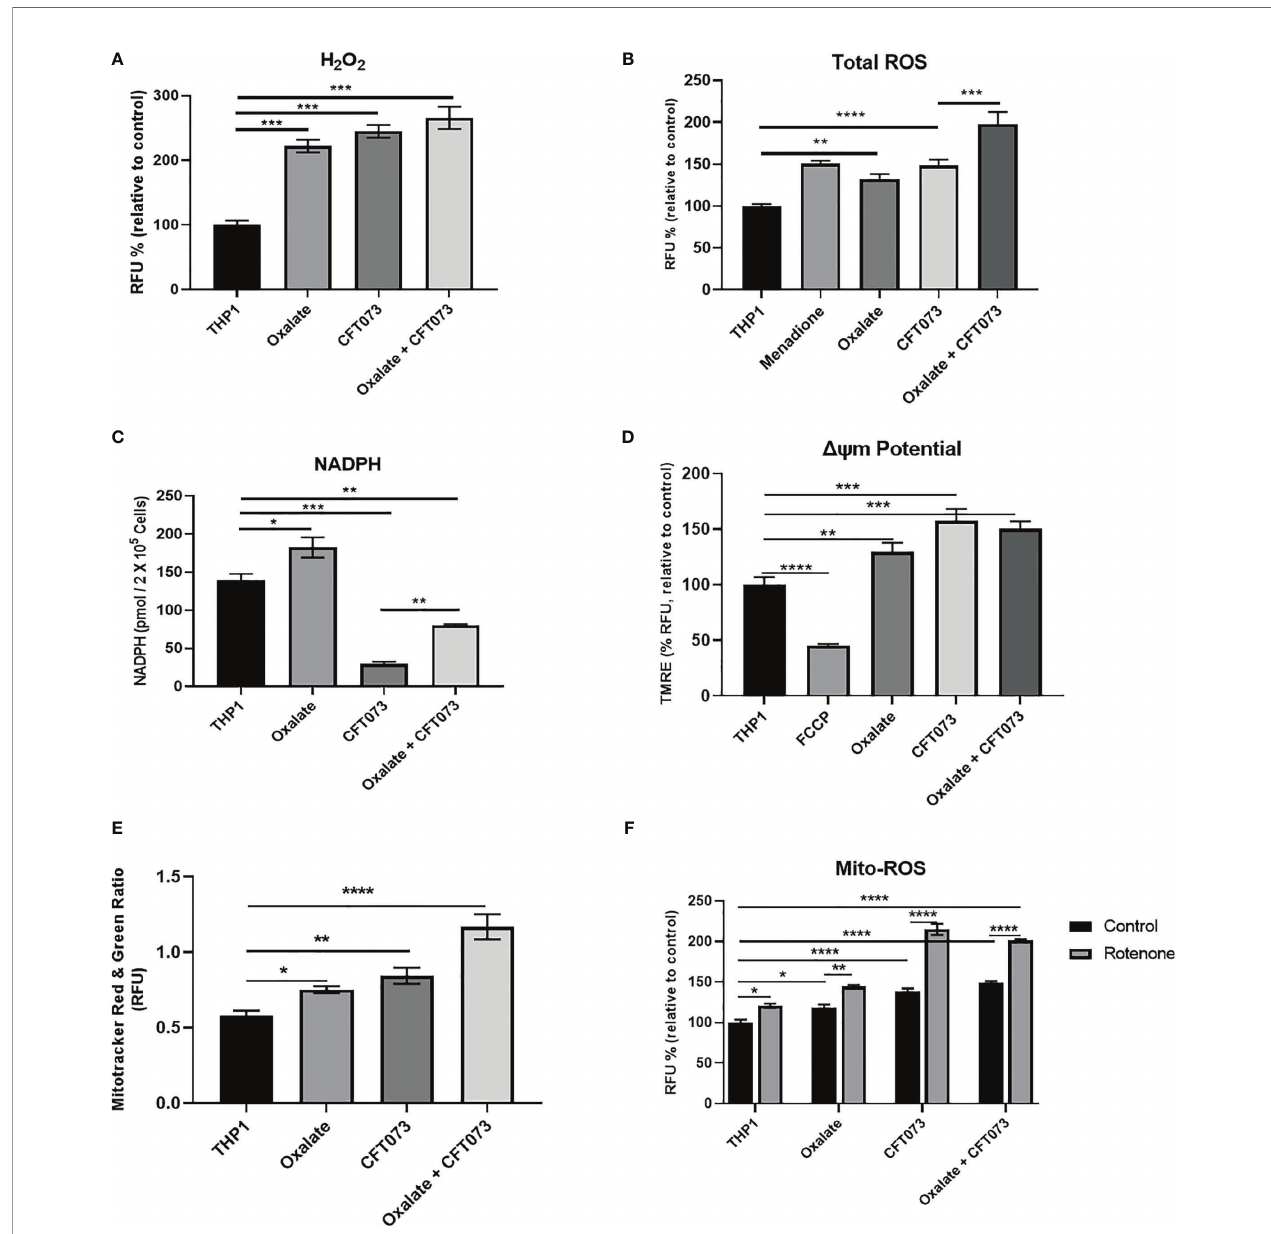
FIGURE 2 | Oxalate increases reactive oxygen species (ROS) levels and mitochondrial membrane potential in THP-1 macrophages. THP-1 macrophages were exposed to oxalate with or without CFT073 (MOI 1:2) prior to assessing (A) Hydrogen peroxide (H 2 O 2 ; Amplex Red Assay), (B) Total ROS (H2DCFDA, fl uorescence dye; Menadione (100 m M)-positive control), and (C) NAPDH levels. (D) Mitochondrial membrane potential was examined using the fl uorescence dye, TMRE. FCCP (50 nM) was included as a control. (E) MitoTracker Red/MitoTracker Green fl uorescence intensity ratio in macrophages. (F) Mitochondrial ROS (superoxide) levels were determined following treatment with or without rotenone (3 µg/ml). All experiments were performed at least three times with n=5 replicates. Data are expressed as mean ± SEM. *p < 0.05, **p < 0.01, ***p < 0.001, ****p < 0.0001 is signi fi cant compared to control THP-1 macrophages or CFT073